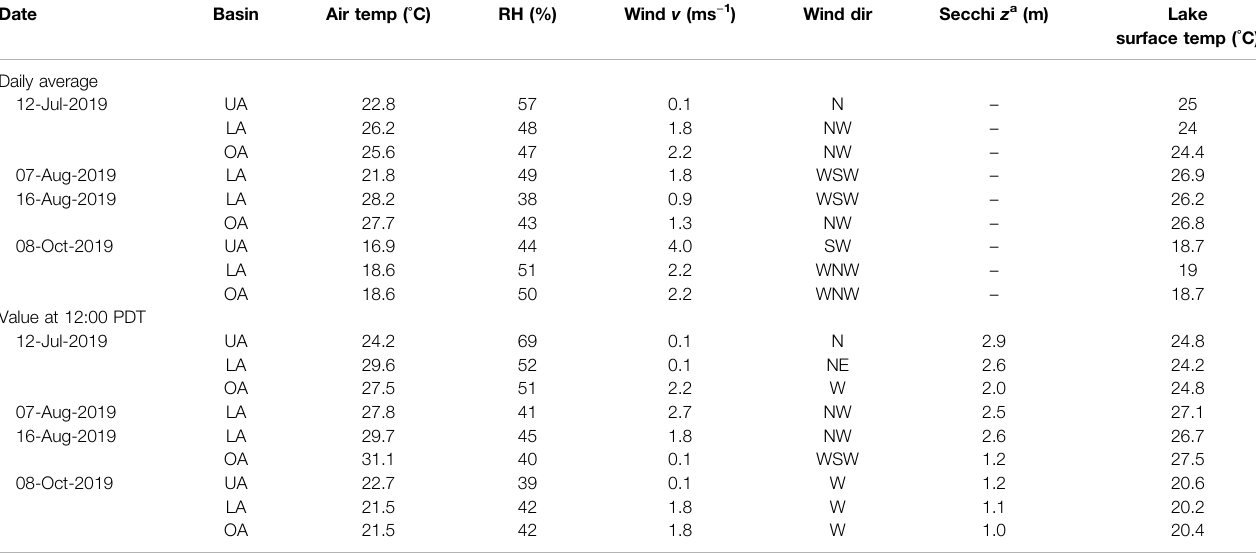
TABLE2| Meteorologicalforcingandlakesurfacetemperaturedataresults.Dataprovided(columnsfromlefttoright)includesamplingdate,basinsampled,airtemperature, relative humidity, wind speed, wind direction, Secchi depth, and lake surface temperature. Generally, the Lower and Oaks arms were windier and have warmer air temperature than the Upper Arm during our sampling events. The Oaks Arm consistently has the lowest clarity based on the Secchi